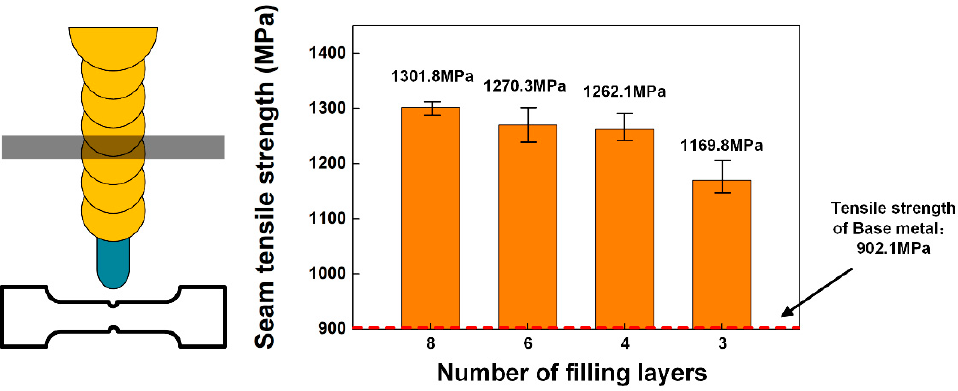
Figure 9. Tensile test results with a notch in the filling layer.